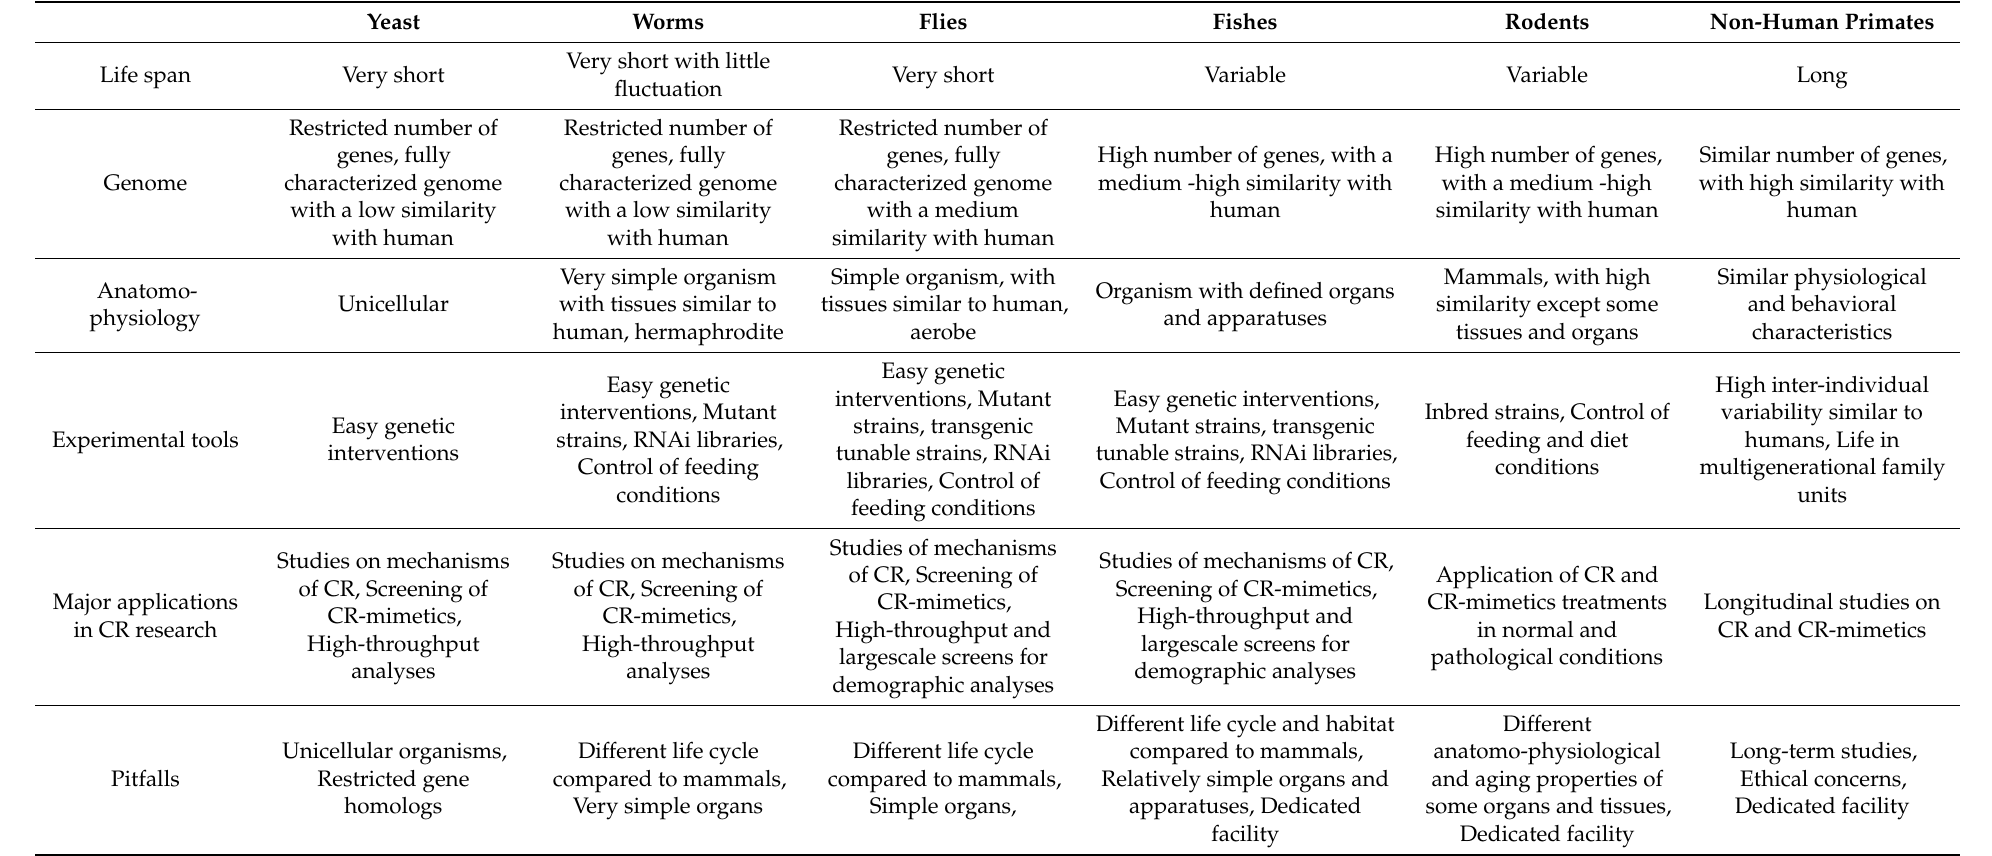
Table 1. Summary of the most relevant properties of the described model